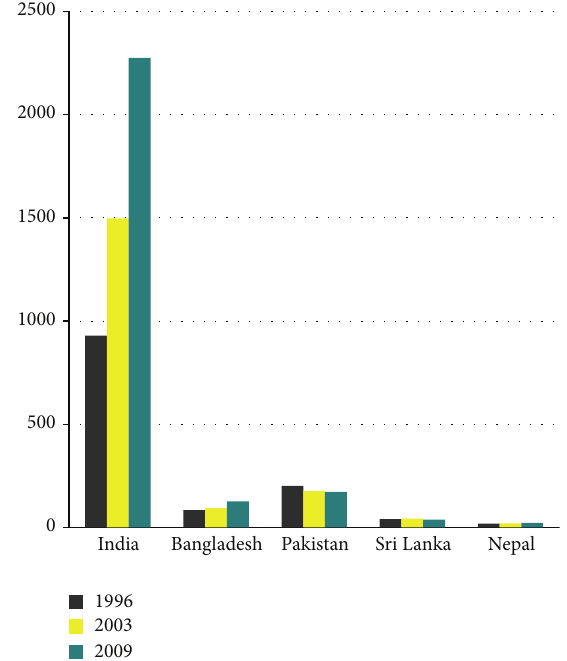
Figure 1: Total public agricultural R&D spending (million $). Source: the World Bank, http://data.worldbank.org/region/south- asia.